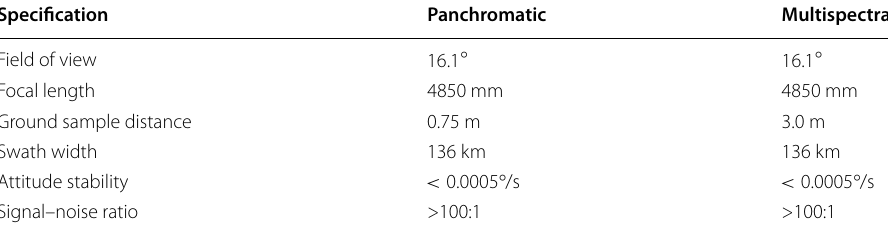
Table 1 Characteristics of the Hongqi-1-H9 wide-range